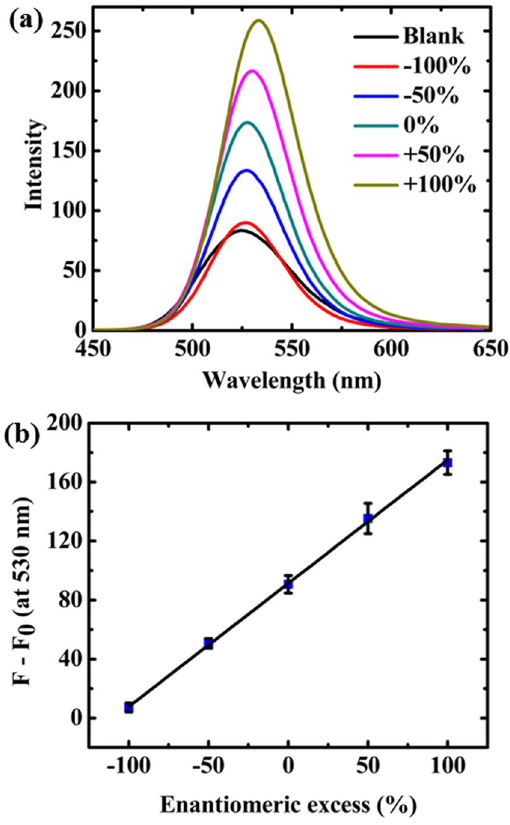
Figure 6. ( a ) Emission spectra of QDs in different enantiomeric excess of D-cysteine (the total concentration of cysteine was 1 mmol L − 1 ). ( b ) The relationship between fluorescence intensity and enantiomeric excess of D-cysteine at total cysteine concentration of 1 mmol L − 1 .